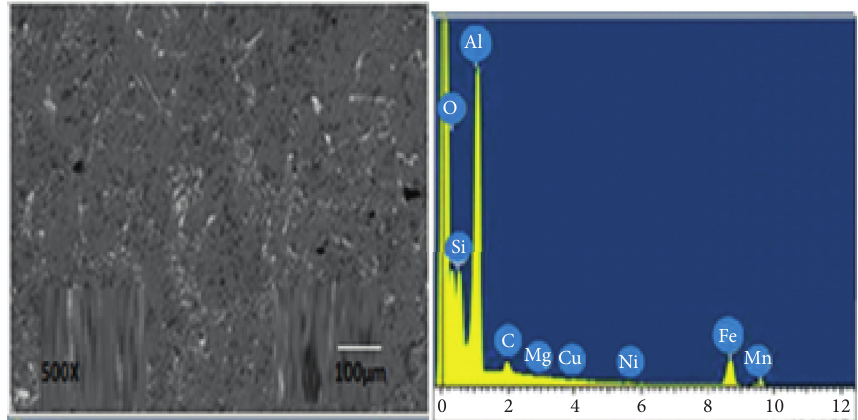
Figure 4: SEM/EDS spectra for as-received AA6061.